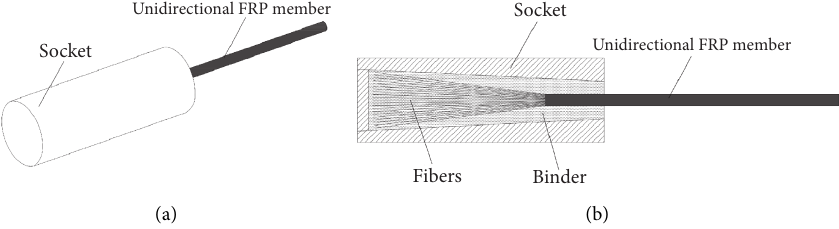
Figure 4: Diagram of dissolution-rebond anchor of a single unidirectional FRP member. (a) Elevation. (b) Profile.